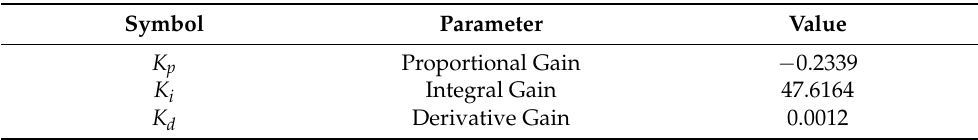
Table 3. PID Controller